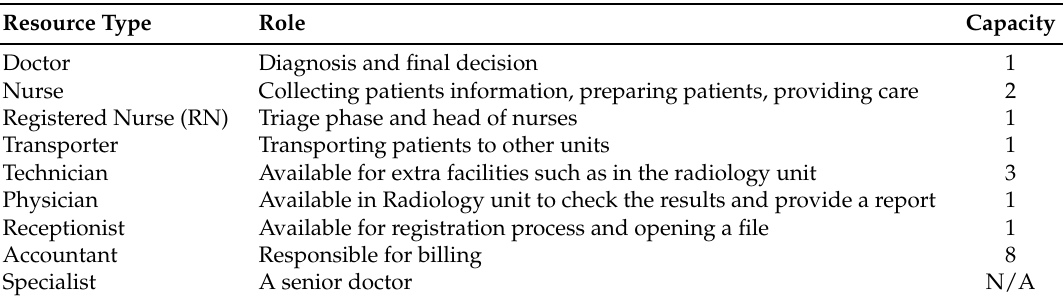
Table 1. Resources list and capacity in the model.